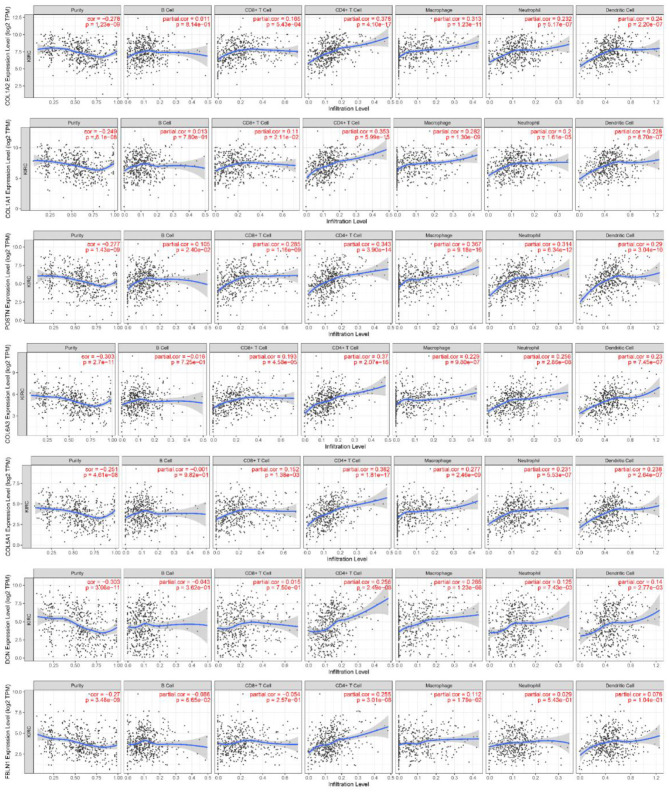
Association of core gene expression in ccRCC with immune infiltrates. Partial correlation analysis of gene expression and tumor immune infiltrate levels (B cells, CD8+ T cells, CD4+ T cells, macrophages, neutrophils, and dendritic cells).